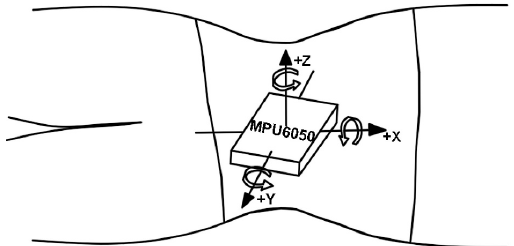
Figure 5. The six-axis motion sensor is oriented in the positive direction of the three coordinate axes on the subject’s body, with the x -axis in the direction of spinal alignment. The subject completes the turning motion with the x -axis as the rotation axis, the z -axis being perpendicular to the plane of the subject’s body, the y -axis being vertical to the x -axis, and the right-hand rule being satisfied. The large fluctuations in the analog output waveforms of the flexible angle and six- axis motion sensors at the same time, as shown in Figure 6, can be used to determine that the subject has rolled over and that the subject’s sleeping position has changed by refer- ring to each subject’s 12 types of sleeping position change data. Each subject was subjected to 12 sleeping-position changes in turn. For each sleeping position, the positive and neg- ative values of ∆ U1 and ∆ U2 for the left and right side of the waist, as well as ∆ U3 and ∆ U4 for the lower and upper spinal strain gauges, were different due to the different di- rections of the upper and lower spine and left- and right-side waist bending. For example, when the subject is lying on his or her left side, the left lumbar flexure sensor will sag and bend, the right lumbar flexure sensor will be close to horizontal, while the upper and lower spine flexure sensors have a certain degree of bending due to the individual’s arched back; when the subject is lying on his back, the upper and lower spine flexure sensors are close to horizontal, while the left and right lumbar flexure sensors have a cer- tain bending deformation. Due to each subject’s differences, the data of the 12 sleeping- position changes were collected from each subject. The number of sleeping-position changes and the sleeping position of the subject during the whole night could be judged according to their sleeping-position change data. Since the subject’s body was twisted and repeatedly moved during the turning process, the signal would fluctuate, so there would be several peaks when there was a turning action. Nonetheless, the signal would not fluc- tuate for some time after the turning action was completed, and the maximum peak was used to judge the subject’s lying position change.